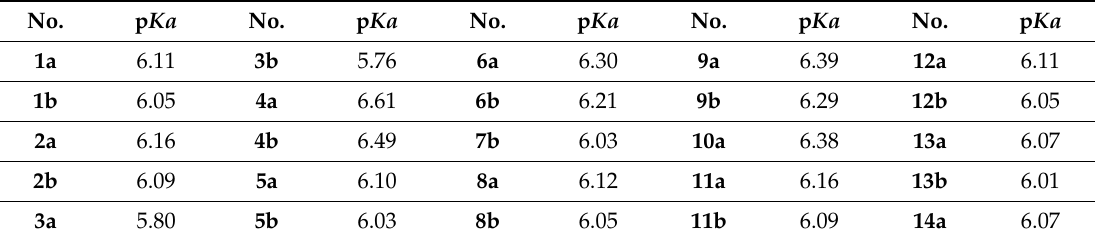
Table 3. p Ka values of title compounds predicted using the Chemicalize web application.